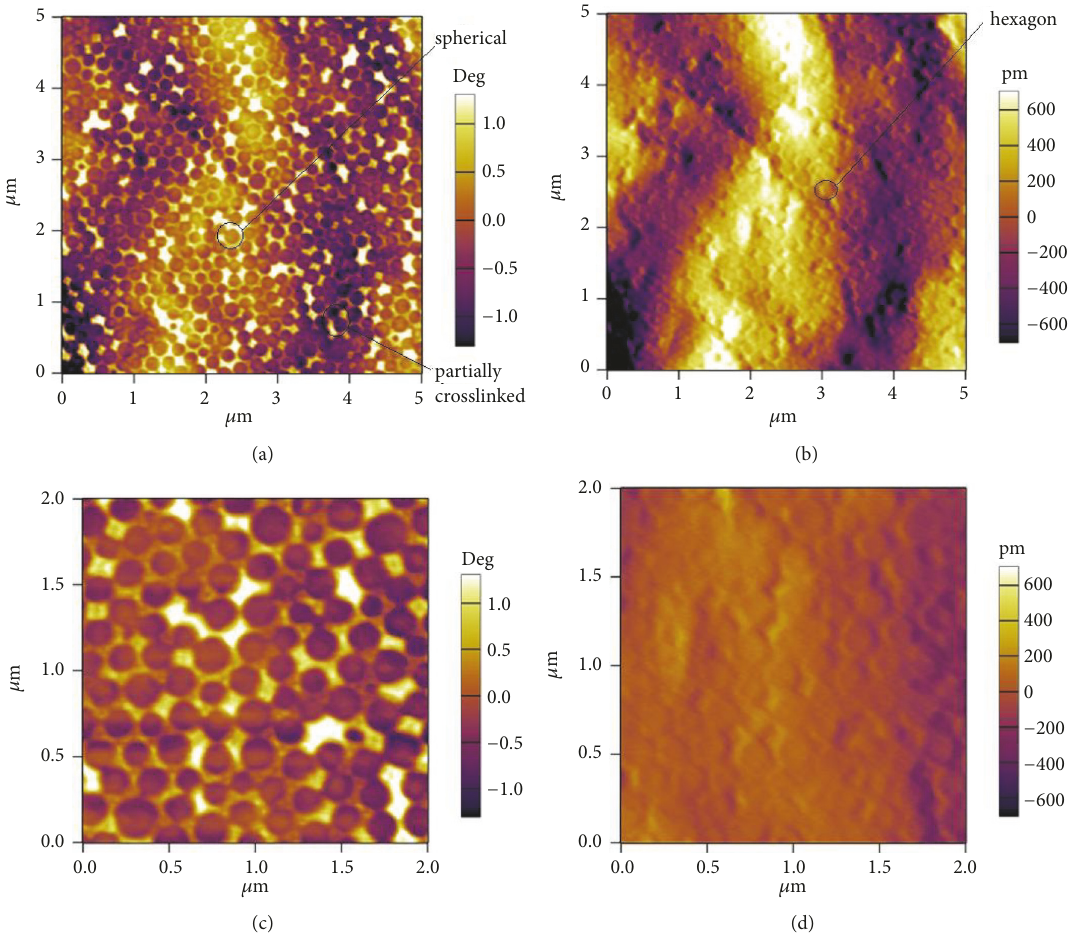
Figure 2: AFM images of a water-borne film after 20 min and film formation at 25 ∘ C ((a) and (c) for horizontal; (b) and (d) for